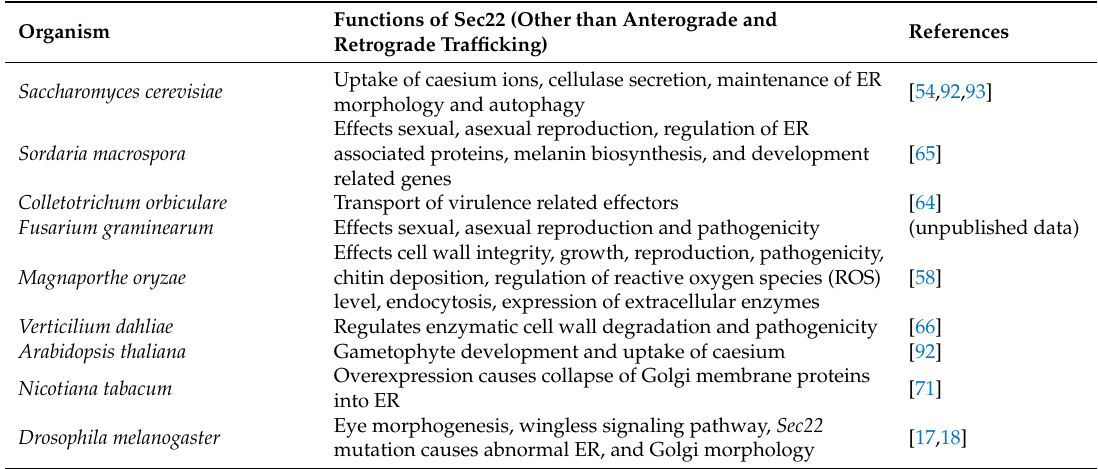
Table 1. Role of Sec22 in different